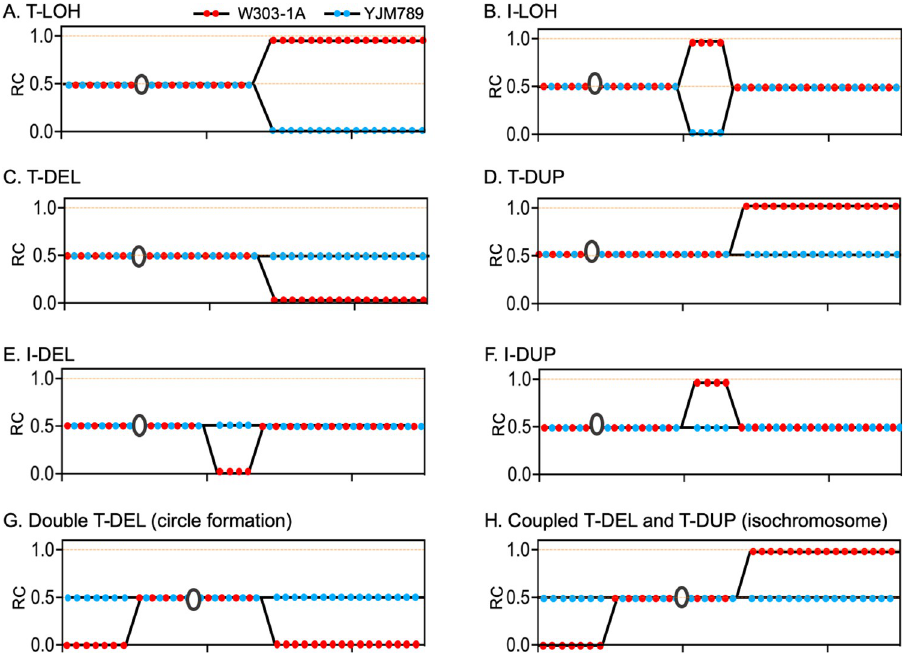
Fig 4. Depictions of various classes of LOH events along one chromosome as analyzed by DNA sequencing or microarrays. The Y-axis shows the ratio of coverage (RC), the number of “reads” for each SNP divided by the average “reads” of the two types of SNPs for the whole genome. Thus, a ratio of 0.5 indicates heterozygosity for a SNP. The RCs for each W303-1A- or YJM789-specific SNP are shown by red and blue circles, respectively. The open black circles indicate centromeres. The X-axis represents the SGD (Saccharomyces Genome Database) coordinate of the chromosome of the reference strain (S288c) numbered from the left to the right telomere. (A) Terminal LOH (T-LOH) event, reflecting a crossover or BIR. (B) Interstitial LOH (I-LOH) resulting from gene conversion or a double-crossover (less likely). (C) Terminal deletion (T-DEL). (D) Terminal duplication (T-DUP). (E) Interstitial deletion (I-DEL). (F) Interstitial duplication (I-DUP). (G) Double T-DEL or I-DUP that contains a centromere. (H) Coupled intrachromosomal T-DEL and T-DUP; isochromosome.